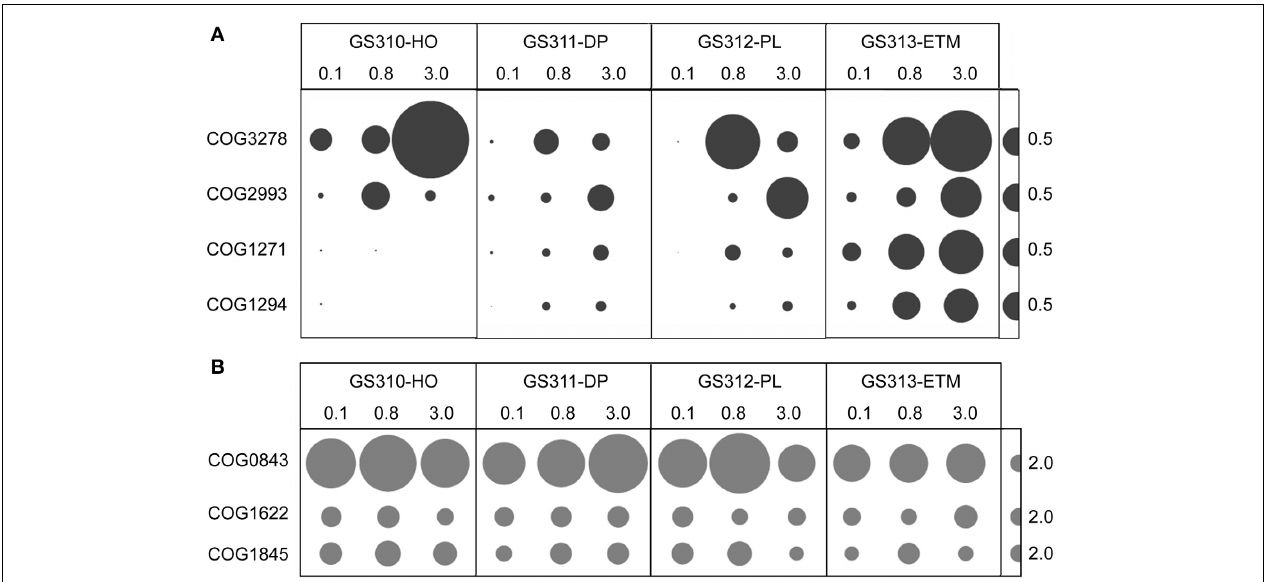
FIGURE 2 | (A) High-affinity terminal oxidase gene categories: COG3278, Cbb3-type cytochrome oxidase, subunit 1; COG2993, Cbb3-type cytochrome oxidase, cytochrome c subunit; COG1271, Cytochrome bd-type quinol oxidase, subunit 1; COG1294, Cytochrome bd-type quinol oxidase, subunit 2. (B) “Housekeeping” heme/copper-type cytochrome/quinol oxidases: COG0843, subunit 1; COG1622, subunit 2; COG1845, subunit 3. Abundance for a functional gene category was calculated as the number of hits to a given category normalized by average bacterial genome equivalents in the